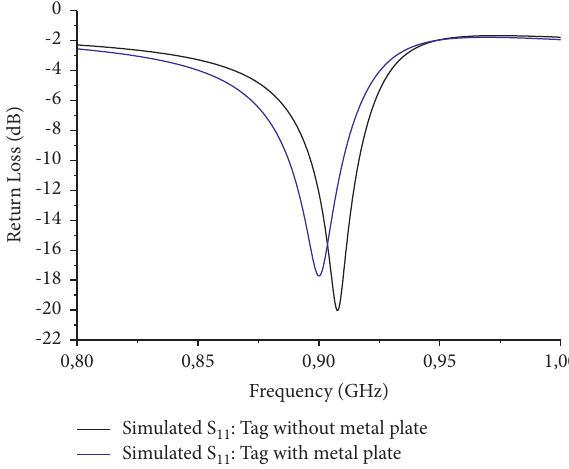
Figure 4: Simulated reflection coefficients of the proposed 3D PILA tag